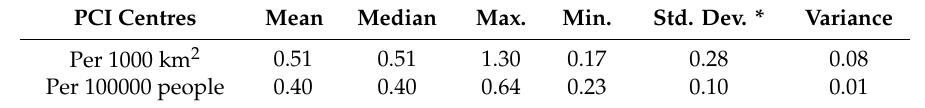
Table 2. Summary statistics of percutaneous coronary intervention (PCI) centres in Poland (2018). PCI Centres